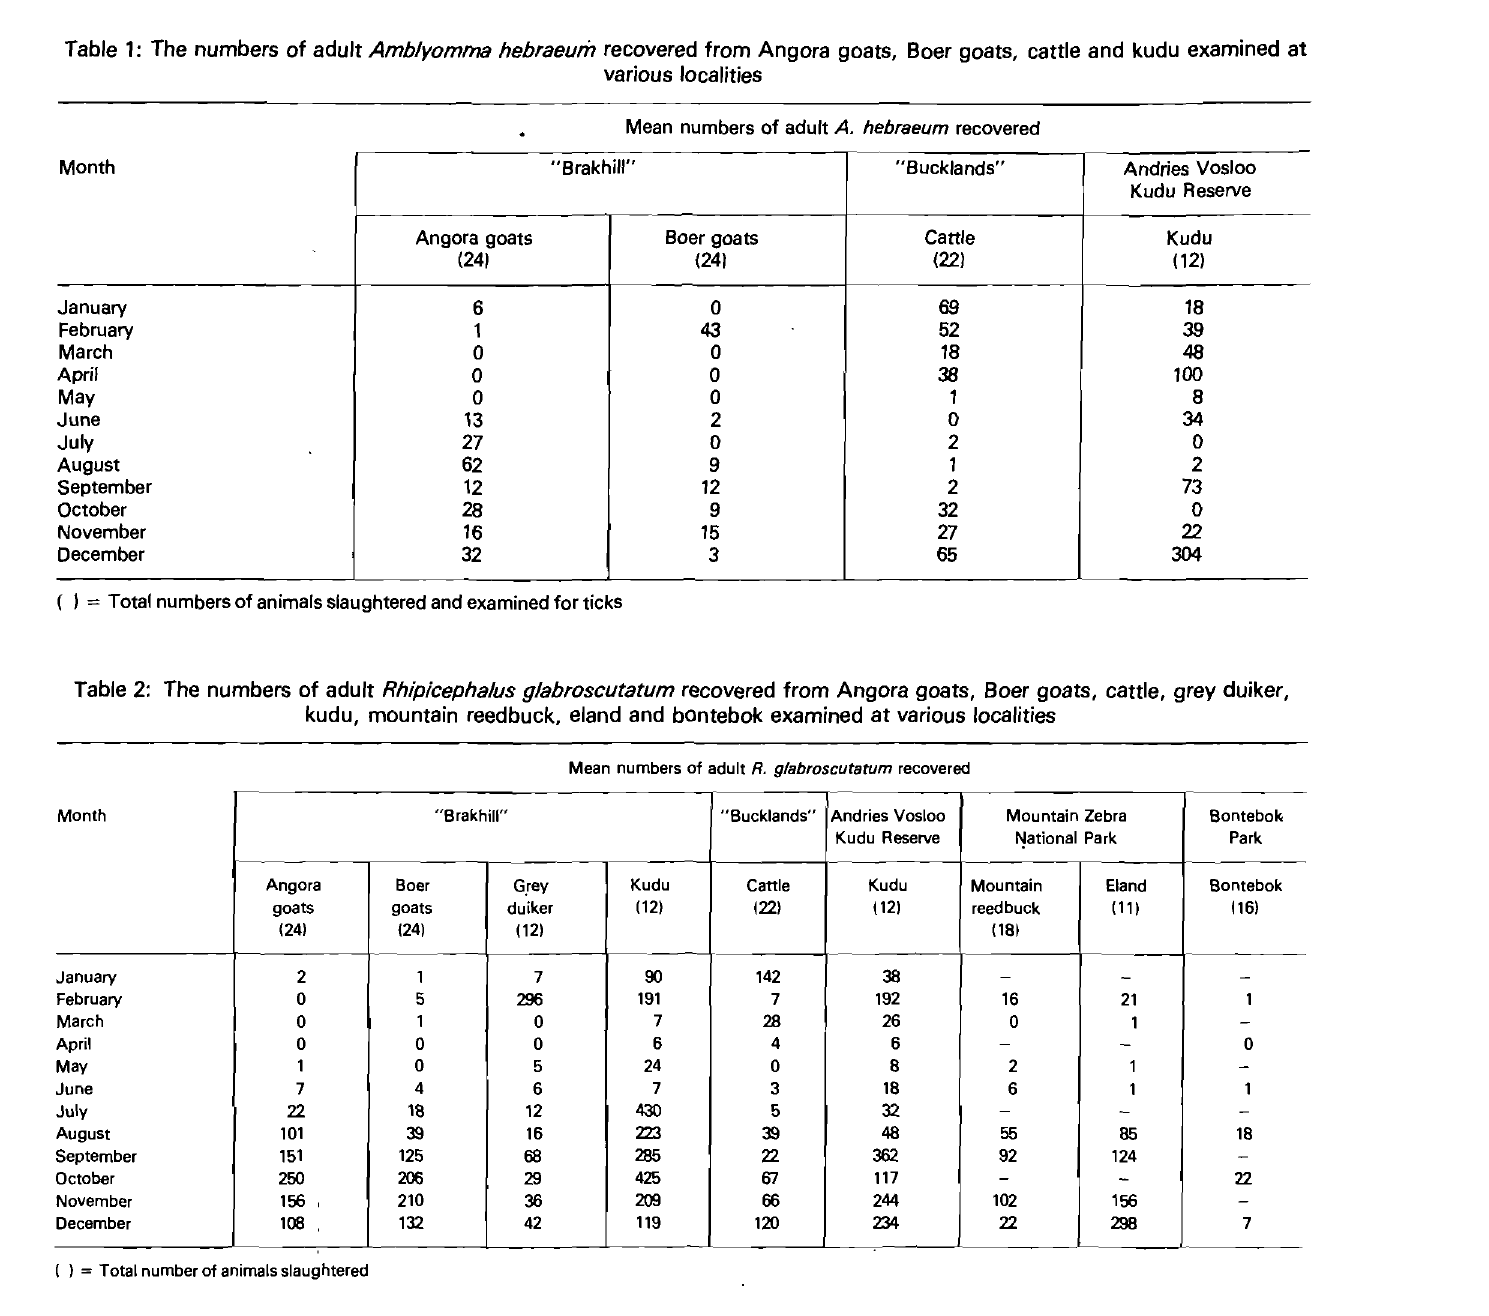
Table 1: The numbers of adult Amblyomma hebraeum recovered from Angora goats, Boer goats, cattle and kudu examined at various localities